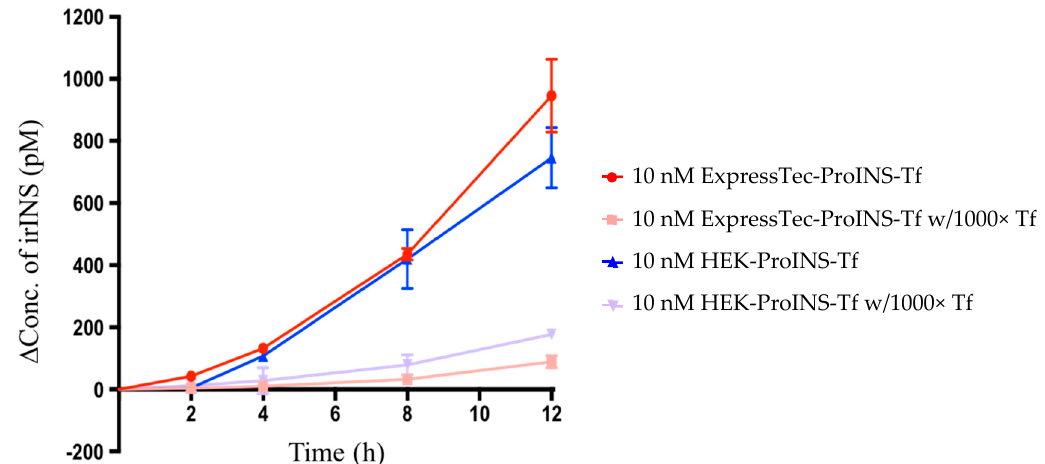
Figure 3. TfR-mediated conversion of ExpressTec-ProINS-Tf in H4IIE cells. H4IIE cells were treated with 10 nM of ExpressTec-ProINS-Tf or HEK-ProINS-Tf in the presence or absence of 1000-fold excess apo-Tf at 37 °C. At the specific time-points, media were collected and insulin concentrations (mean ± SD, n = 3) were measured using INS-specific RIA. The concentration of irINS-Tf was calculated using human insulin as a standard curve from 12 to 1200 pM according to the manufacturer’s instructions.